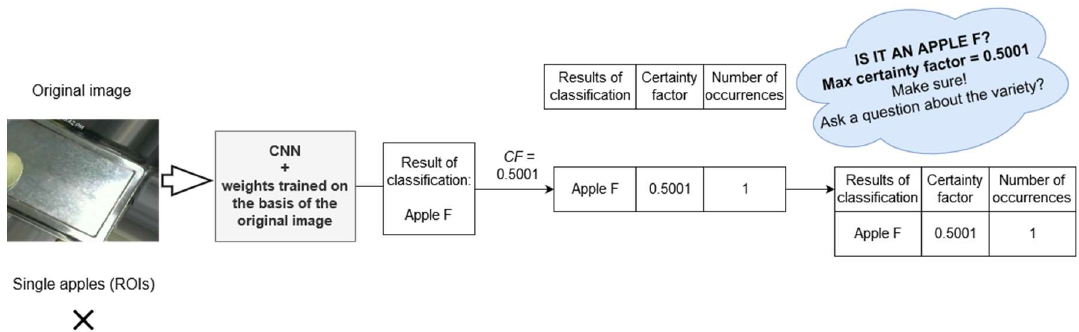
Figure 5. An example of classification using the proposed system: uncertain classification (based only on the original image).